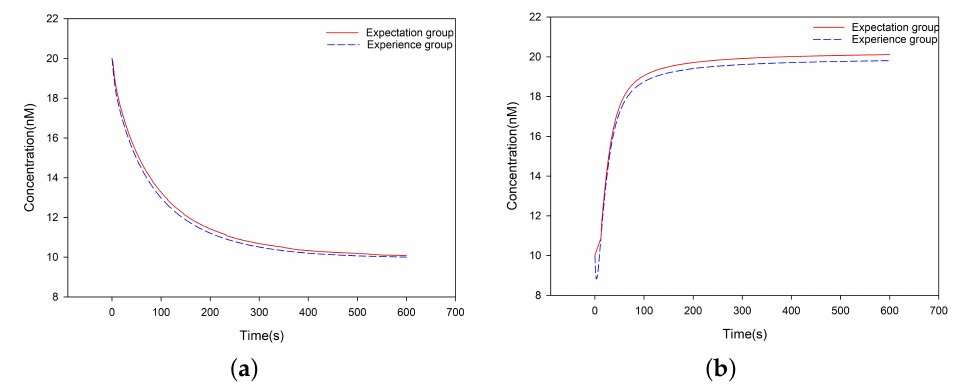
Figure 4. Simulation results. ( a ) The evolution of the concentration of Species A in the DR-module. The whole process takes 600 s, and the concentration of A is reduced from 20 nM to 10 nM. ( b ) The evolution of the concentration of Species A in the CR-module. The whole process takes 600 s, and the concentration of A is doubled.